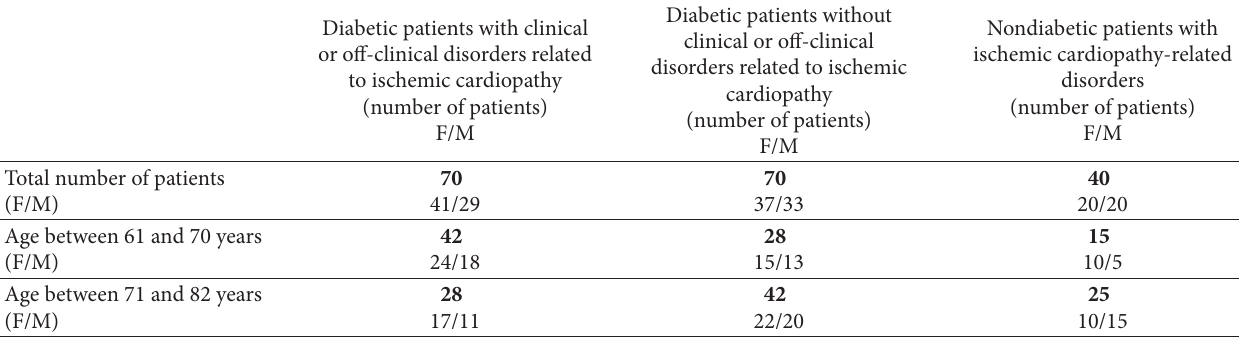
T 2: e groups of patients taken in the study.